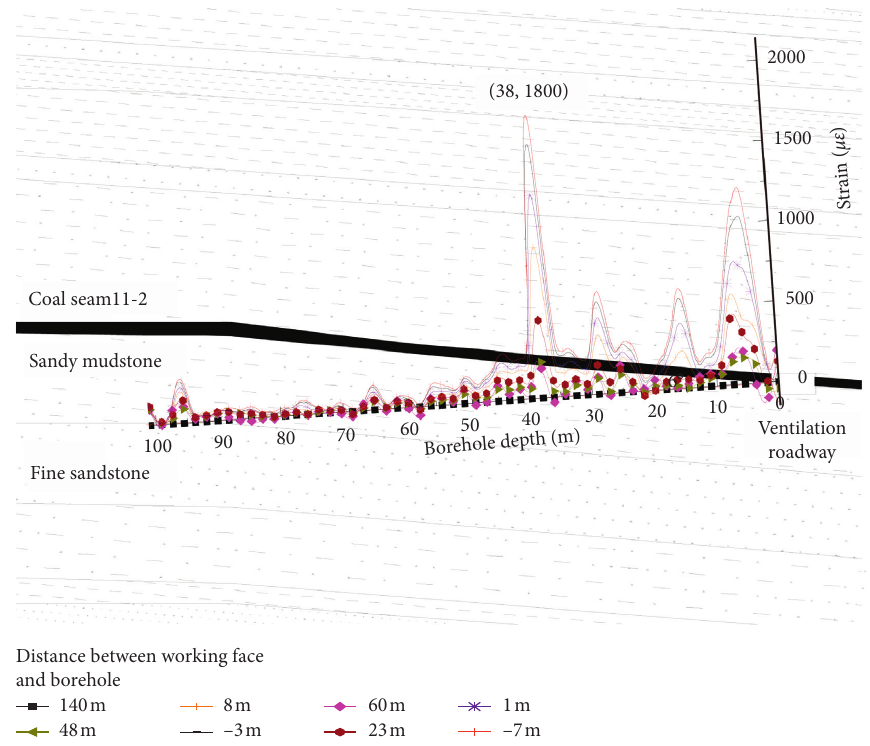
Figure 3: Relationship between the strain distribution of sensing optical cables and